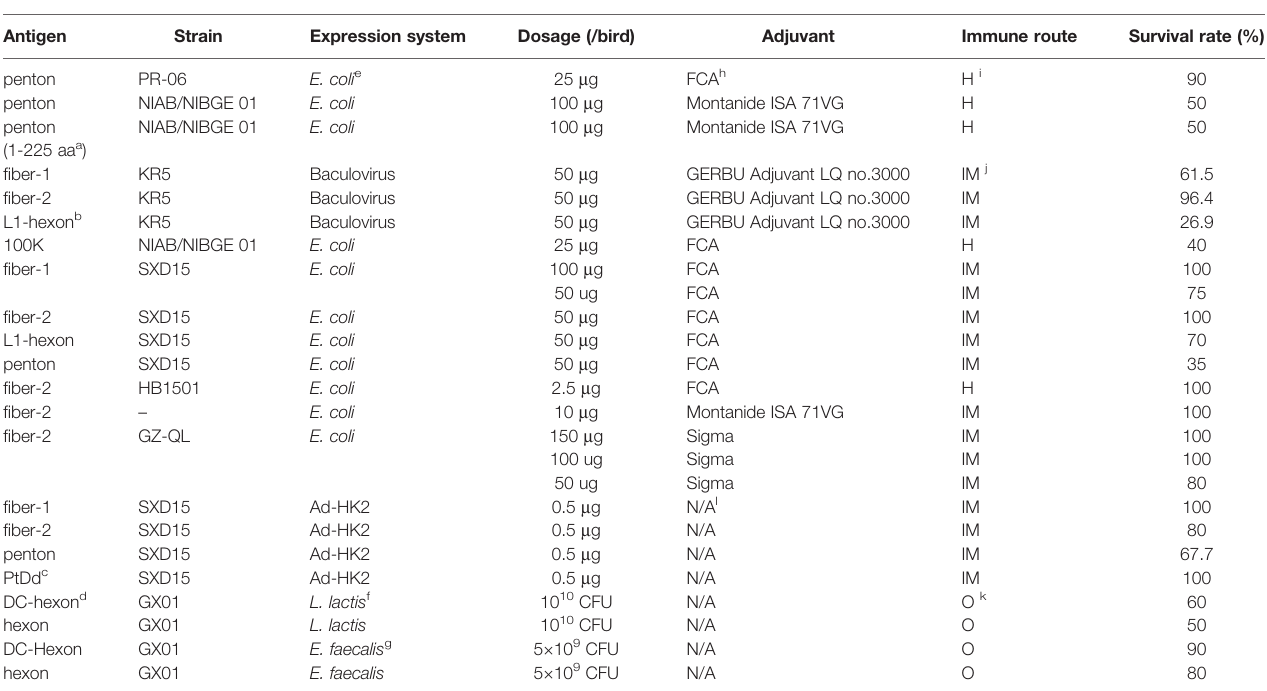
TABLE 2 | List of subunit vaccines against